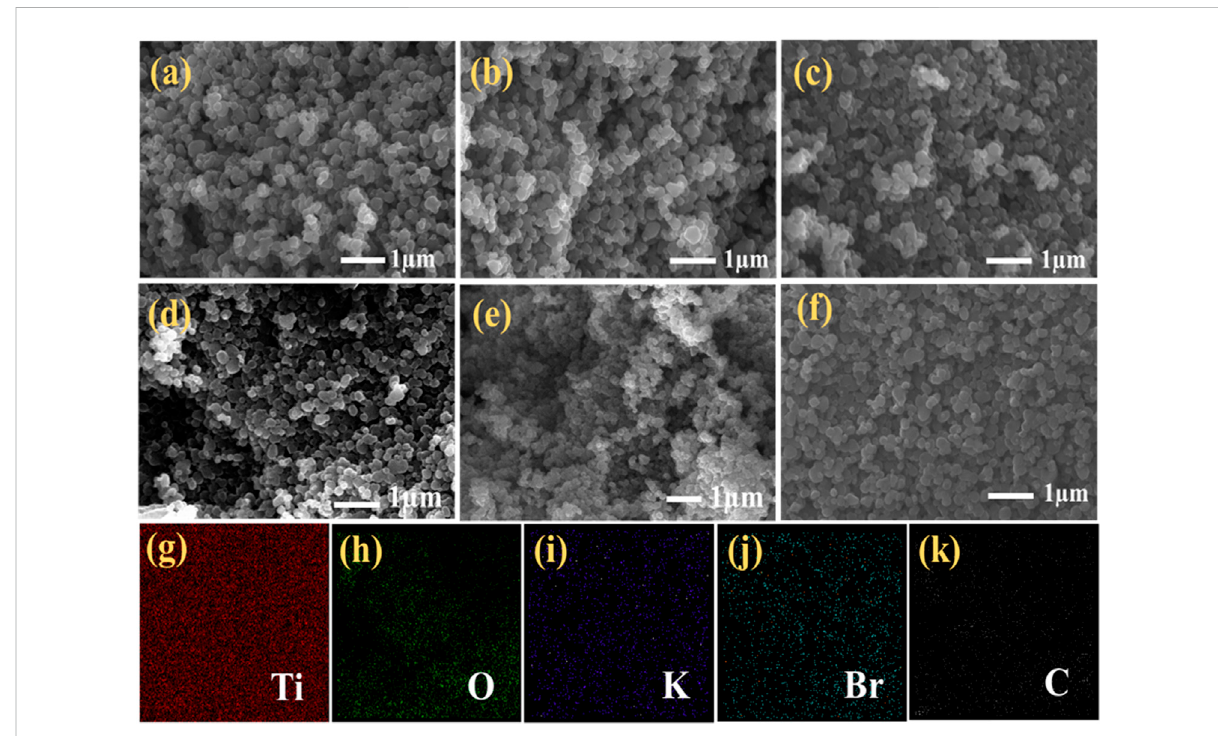
Where I/S is the current density (mA/cm 2 ), and Δ t is the discharging time measured in seconds. Areal speci fi c capacitance (C A ) based on scan rate from 10 to 100 mV/s is shown in Figure 10A. It is observed that the speci fi c capacitance shows decreasing behavior with the increase in scan rate. Here the untreated sample has the areal capacitance of approximately 15.4 mF/cm 2 at 10 mV/s. Further increase in plasma treatment time as 30 s and 60 s, we observe a gradual increase in areal capacitance, approximate 18 mF/cm 2, and 20 mF/cm 2, respectively. As we reach the time at 80 s, the C A values enhanced approximately up to 20.826 at 10 mV/s, as shown in Figure 10A. Further, at 100 s of microwave plasma treatment, TiO 2 shows the lowest value of areal capacitance of 15.37 mF/cm 2 at 10 mV/s near the untreated sample. Similarly, the areal capacitance behavior is also determined from the GCD curve at a current density of 0.2 – 1.4 mA/cm 2, as shown in Figure 10B. For untreated sample the C A approximate ~225 mF/cm 2 at 0.2 mA/cm 2 current density. As the plasma treatment time increases, the areal capacitance becomes 85 mF/cm 2 , 81 mF/cm 2 , and 230 mF/cm 2 for 30, 60, and 80 s